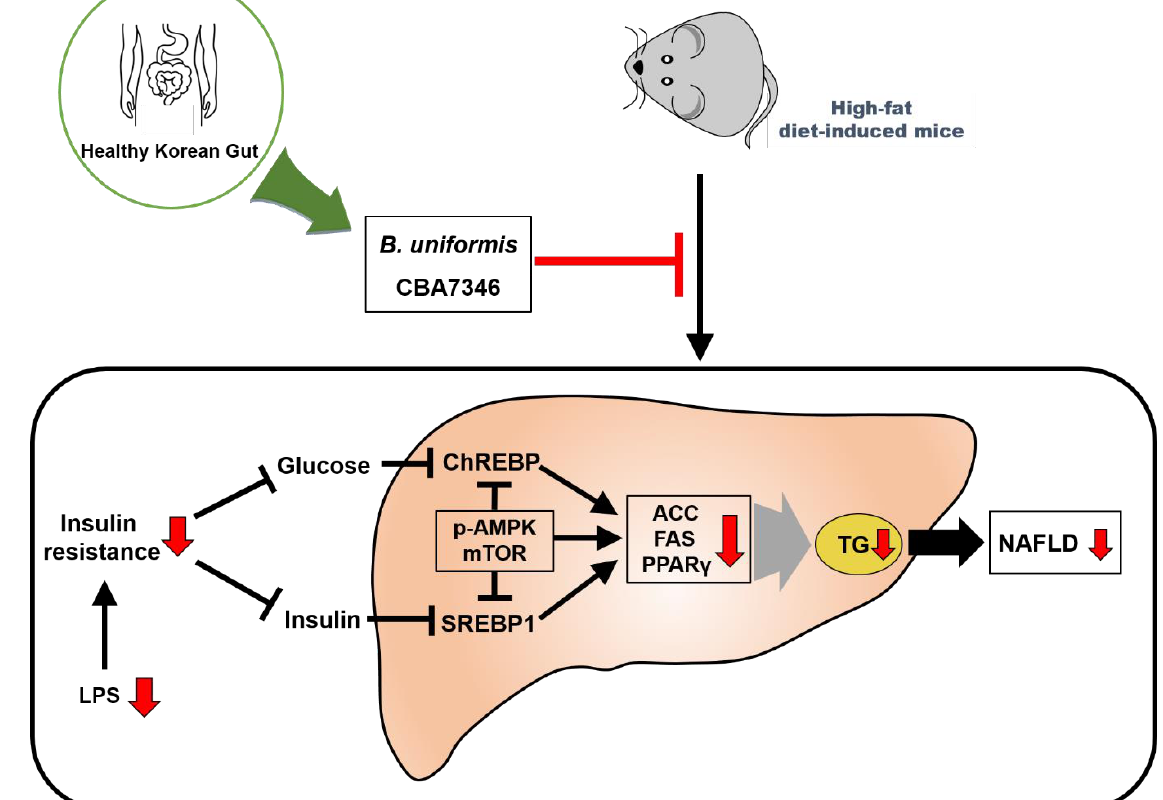
Figure 7. Presumed mechanism for how Bacteroides uniformis CBA7346 interfered with lipid accumulation in mice with high-fat diet-induced non-alcoholic fatty liver disease. LPS: lipopolysaccharide. ChREBP: carbohydrate response element binding protein. SREBP1: sterol regulatory element-binding protein 1. p-AMPK: phospho-AMP-activated protein kinase. mTOR: mammalian target of rapamycin. ACC: acetyl-CoA carboxylase. FAS: fatty acid synthase. PPARγ: peroxisome proliferator-activated receptor gamma. TG: Triglyceride. NAFLD: non-alcoholic fatty liver disease.